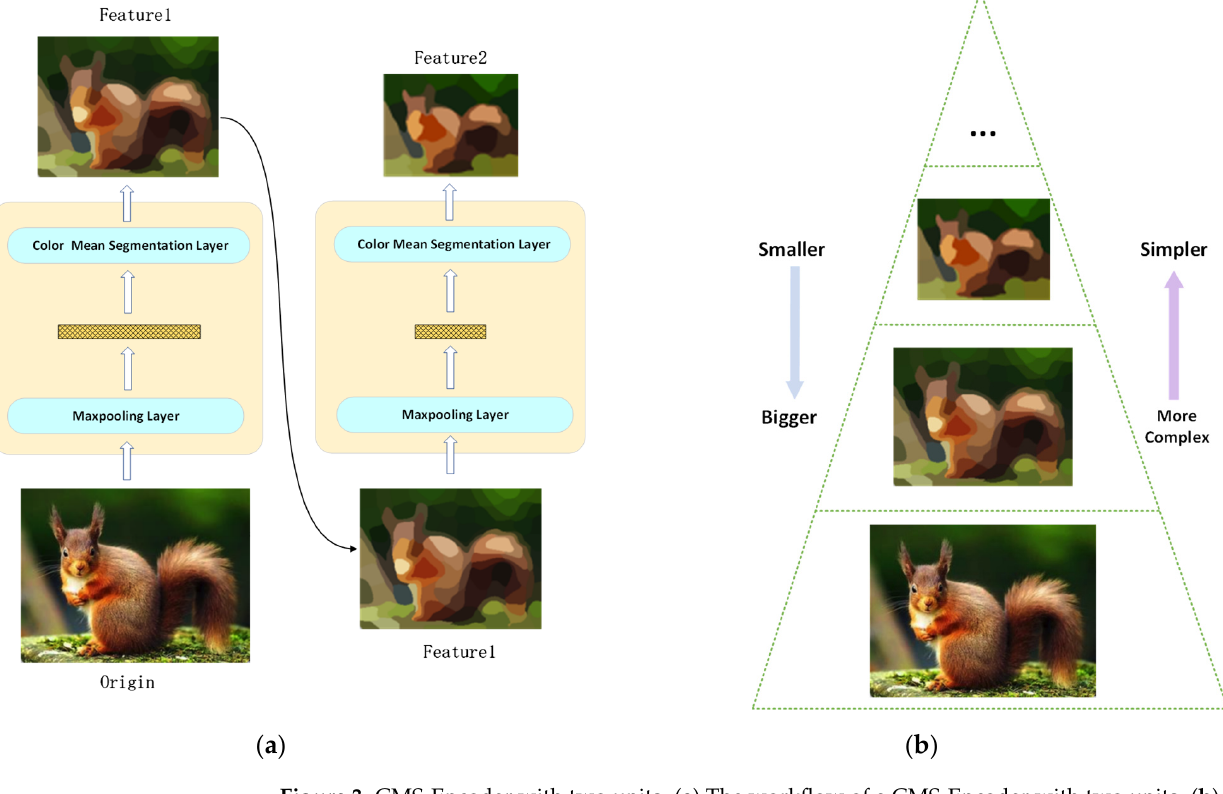
Figure 3. CMS-Encoder with two units. ( a ) The workflow of a CMS-Encoder with two units. ( b ) The “feature pyramid” extracted by the two-unit CMS-Encoder.